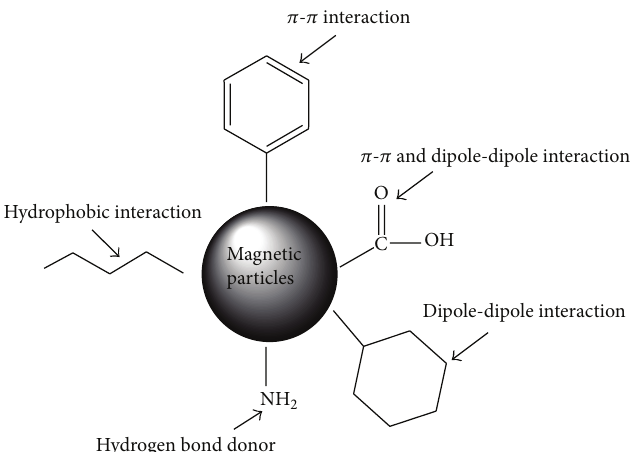
Figure 2: Magnetic nanoparticles of silica-coated Fe 3 O 4 modified with different functional groups and their processes of